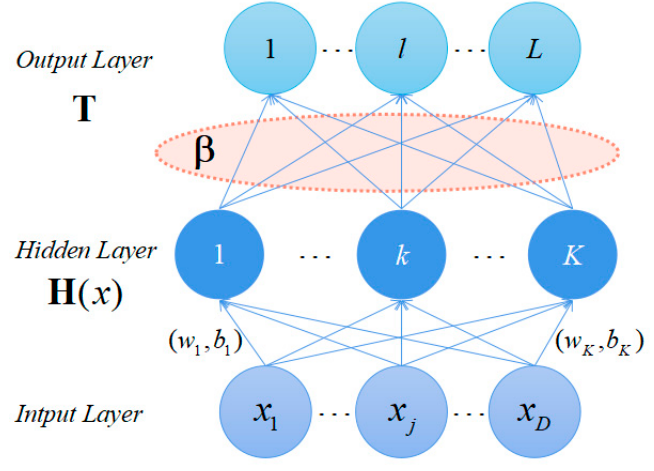
Figure 1. Network Structure of the ELM.